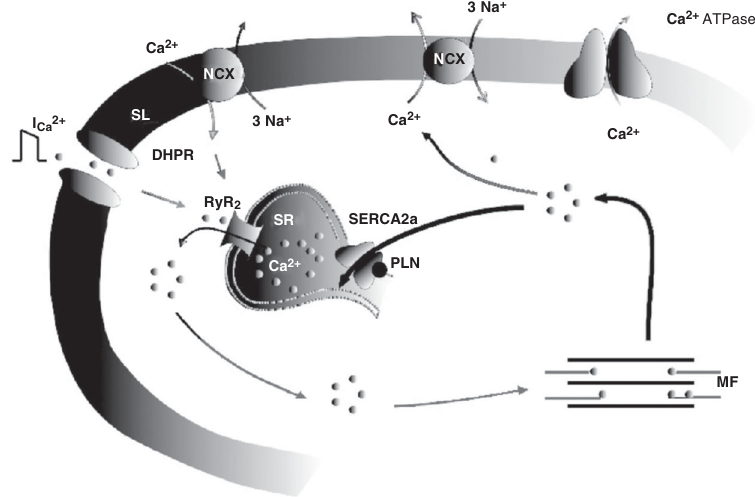
Figure 1. Central players of excitation-contraction coupling (ECC) in cardiac muscle. Scheme of the ECC mechanism in cardiac muscle. Upon depolarization, Ca 2+ influx through L-type Ca 2+ channels or dihydropyridine receptor (DHPR) triggers the release of more Ca 2+ from the sarcoplasmic reticulum (SR). This Ca 2+ binds to the myofilaments (MF) to produce contraction. Part of the Ca 2+ is then extruded outside of the cell through the Na + / Ca 2+ exchange mechanism (NCX), working in the forward mode, but most of it is re-taken up by SR Ca 2+ -ATPase (SERCA2a). Phospholamban (PLN) is a small SR protein associ- ated with SERCA2a. The state of PLN phosphorylation regulates the activity of this Ca 2+ pump. RyR 2 = ryanodine receptor; SL = sarcolemma. Figure 2. Phospholamban phos- phorylation leads to an increase in SR Ca 2+ uptake which accel- erates relaxation and enhances SR Ca 2+ load. More Ca 2+ is then available for release from the SR, resulting in increased con- tractility. Thus, phospholamban is a major regulator of myocar- dial relaxation and contractility. SR = sarcoplasmic